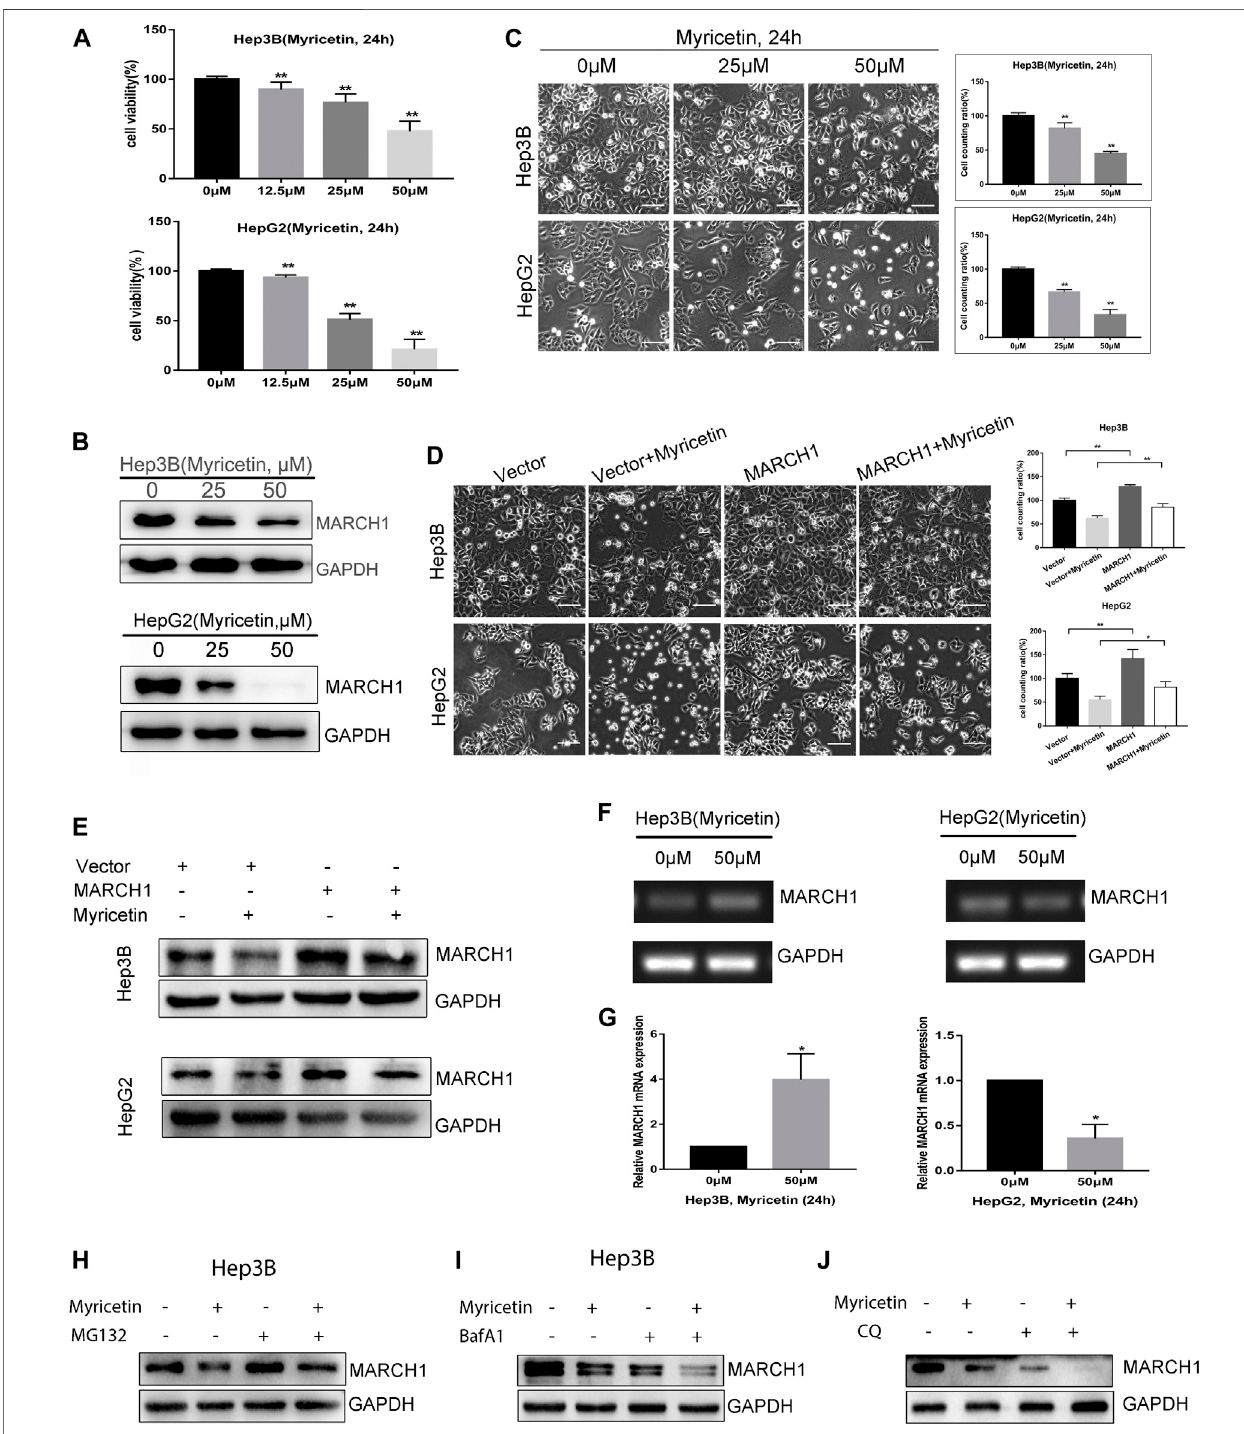
FIGURE1|(A) TheviabilityofHCCcellsassessedbyCCK-8reagentaftermyricetintreatmentfor24 h. (B) MARCH1expressioninHep3BandHepG2cellstreated with myricetin for 24 h detected by Western blot. (C) Images showing the viability of HCC cells incubated with myricetin for 24 h. Surviving cells were statistically and quantitatively analyzed (bar: 100 μ m). (D) HCC cells, transfected empty or MARCH1 plasmids, were treated with 50 μ M myricetin for 24 h. Cells state as shown, bar: 100 μ m. (E) MARCH1 expression was detected by Western blot. (F) MARCH1 mRNA in HCC cells treated with 50 μ M myricetin for 24 h measured using agarose gelelectrophoresis.Representativeimagesareshown.GAPDHisusedastheloadingcontrol. (G) ThemRNAlevelofMARCH1 ofHCCcellsincubatedwithmyricetinfor 24 hanalyzedbyqRT-PCR. (H) Hep3Bcellspretreatedwith0.25 μ MMG132for4 handwith50 μ Mmyricetinfor24 h.MARCH1expressionwasmonitoredbyWestern blot. (I) Hep3Bcellspretreatedwith100 nMBafA1for8 handthentreatedwith50 μ Mmyricetinfor24 h.MARCH1expressionwasanalyzed. (J) Hep3Bcellspretreated with 40 μ M CQ for 4 h and then treated with 50 μ M myricetin for 24 h. MARCH1 expression was analyzed. All data are from the results of the three experiments, presented as the means ± SD. * represents p < 0.05, ** represents p < 0.01.